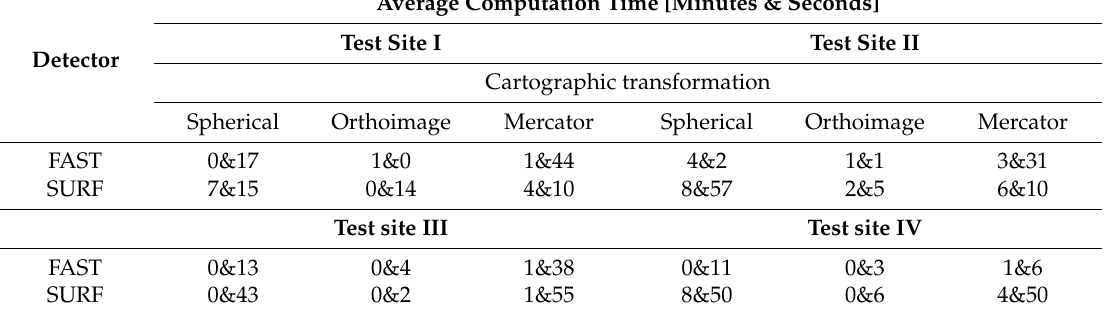
Table 2. Time for detection and matching of characteristic points for particular projections of point clouds, for test sites I and II (both scenarios).